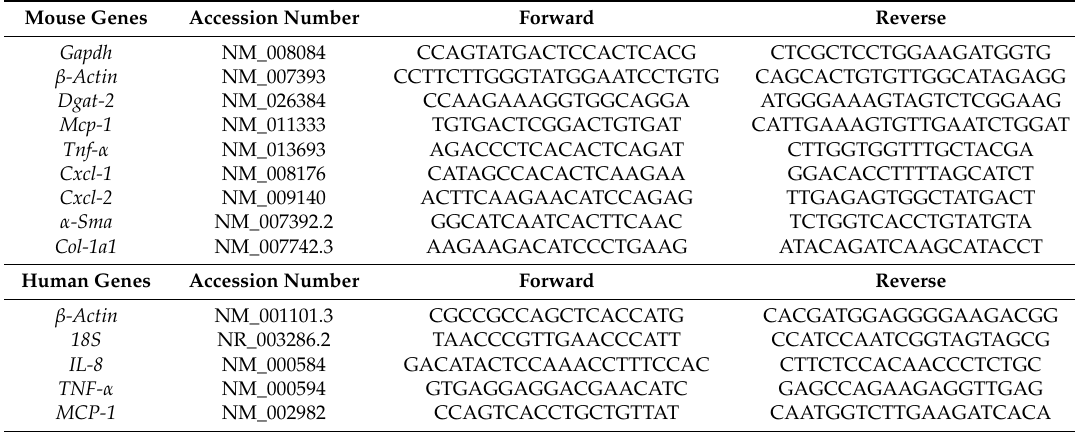
Table 1. Primer pair